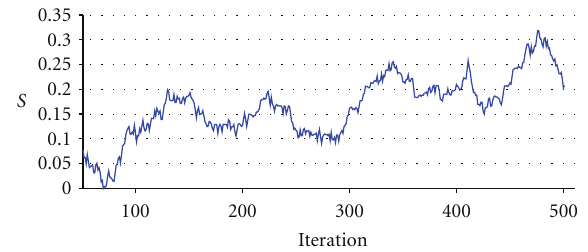
Figure 18: Experimental results of the temporal TAP adaptation framework over the old TAP framework:improvement test. plot of S against number of iterations. A single point on the graph represents a full game episode. S depicts the performance di ff erence in TTAP team versus TAP